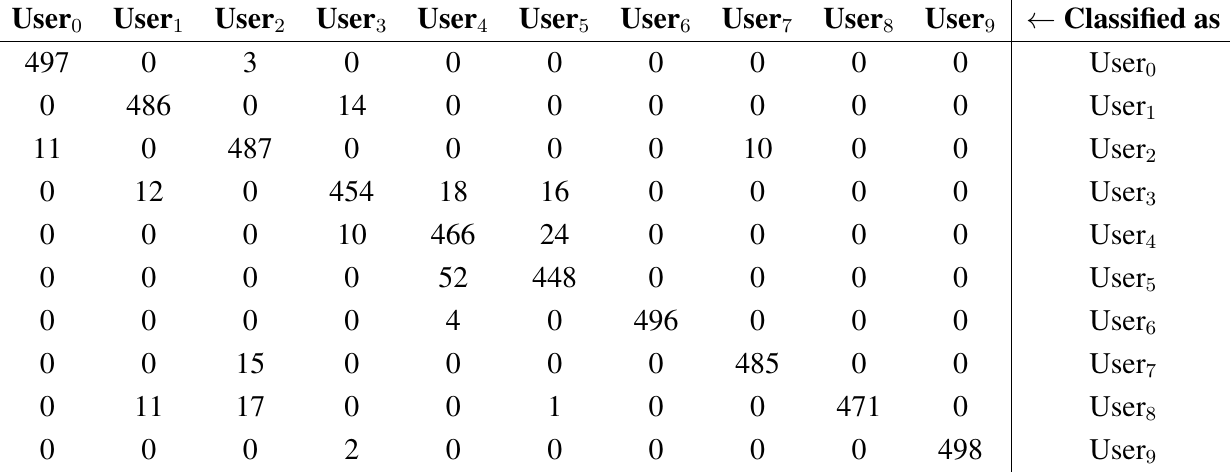
Table 10. Aggregate confusion matrix for support vector machine based on 10 times 10-fold cross-validation for 10 subjects’ stepping